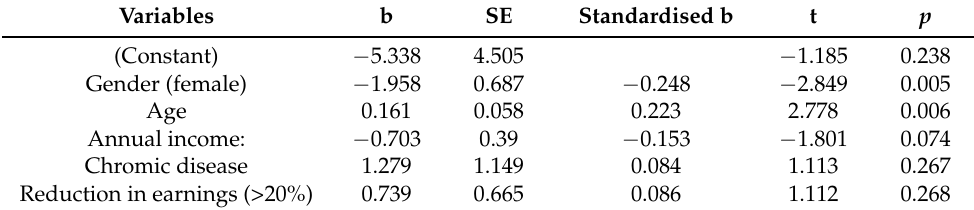
Table 4. Regression analyses of total GDS score on the socioeconomic